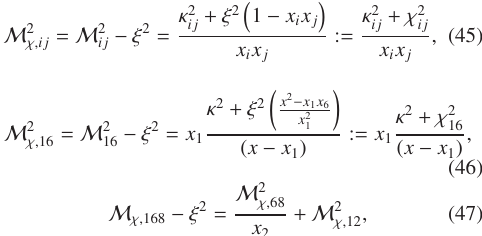
the factor λ is interpreted as the scale of the renormaliza- tion group equations in Euclidean space and if h ( x 0 ) = 0 (cf. [14,